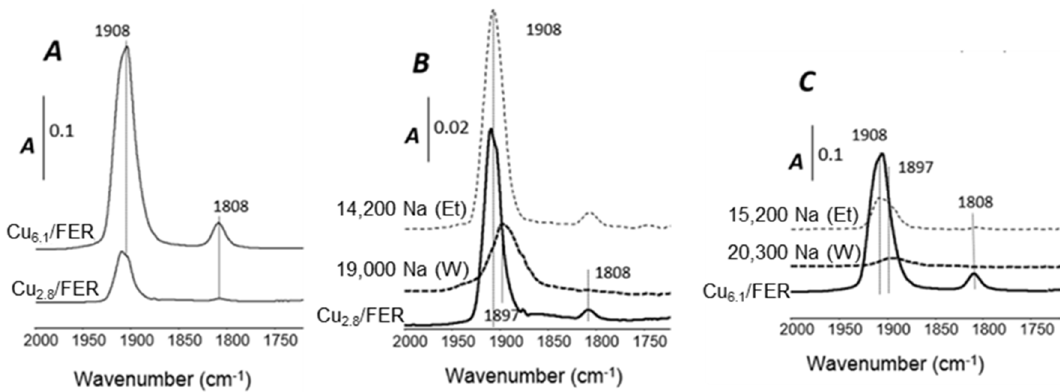
Figure 6. FT ‐ IR spectra of NO adsorption. ( A ) comparison of Na ‐ free copper ‐ exchanged zeolite; ( B ) effect of Na deposit depending on the solvent over Cu 2.8 /FER; ( C ) effect of Na deposit depending on the solvent over Cu 6.1 /FER.